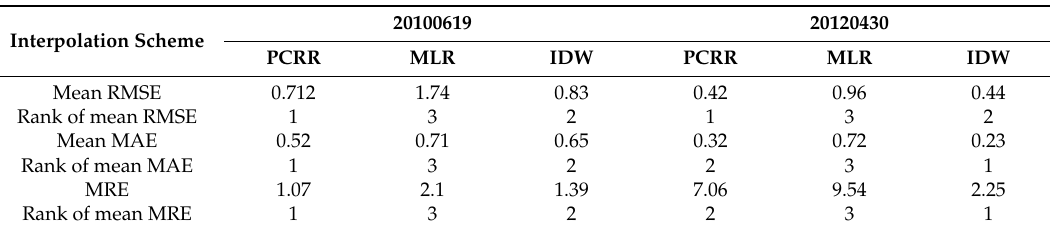
Table 9. Cross-validation performance and ranking of different interpolation schemes for simulating flood events